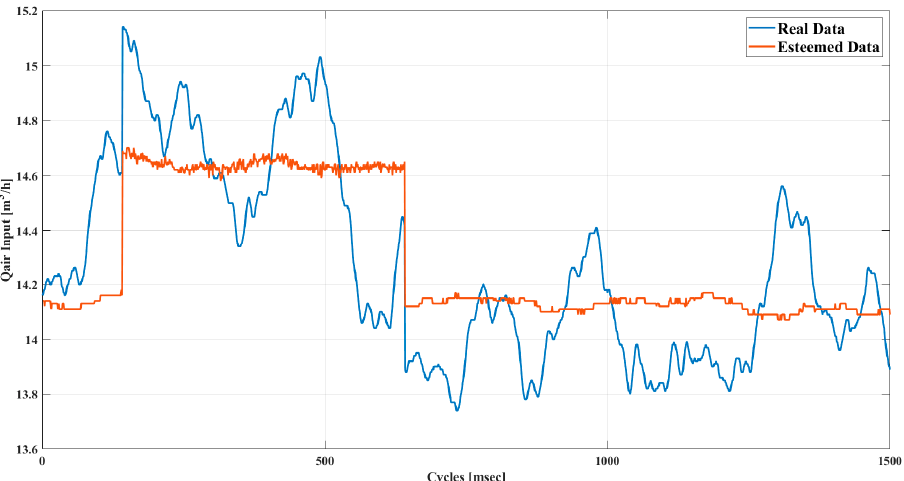
Figure 14. Comparison between actual inlet air flow rate and the esteemed one in an anomalous status.